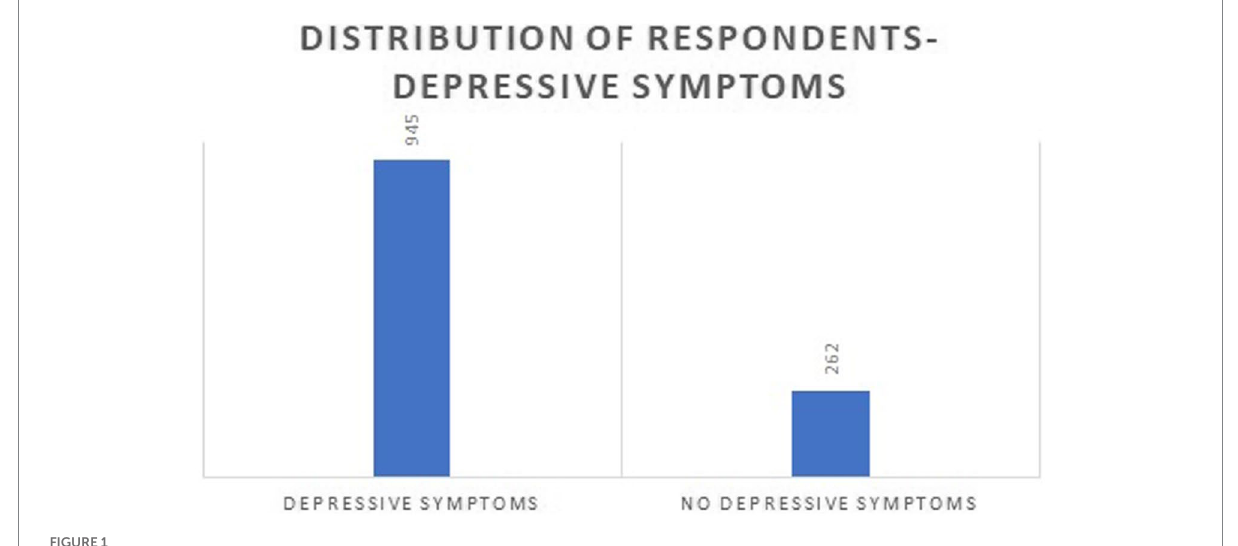
FIGURE 1 Distribution of Respondents with respect to their depressive